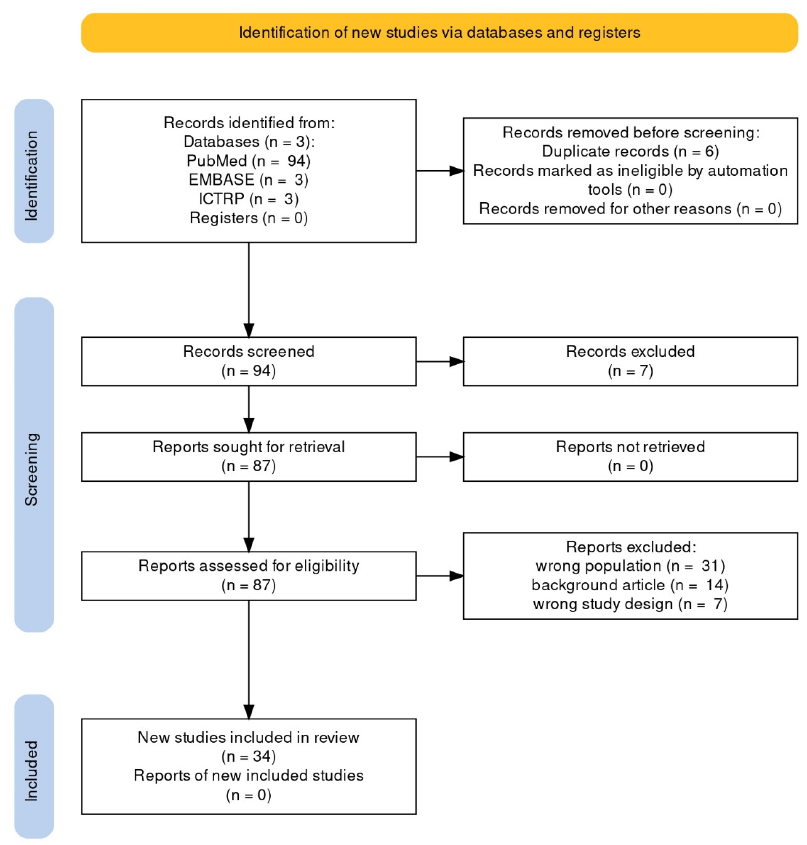
Figure 1. PRISMA flowchart of systematic review article selection process.